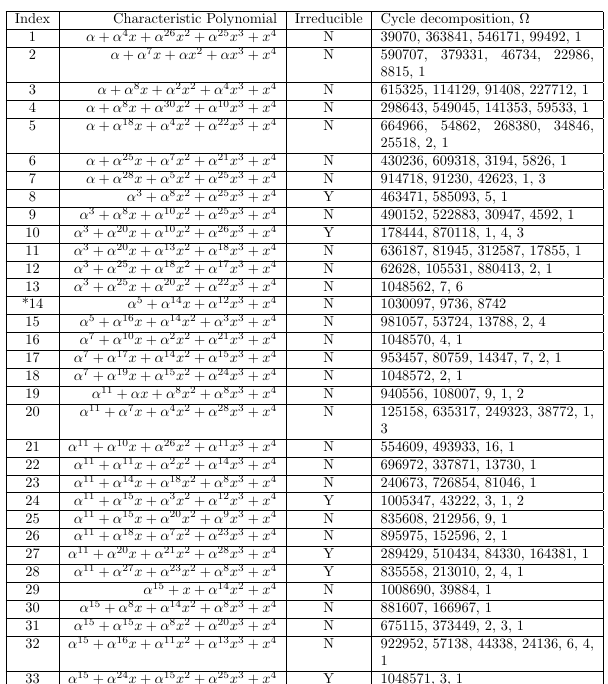
Table 2. Complete cycle decompositions of the WG- NLFSR for n = 4 over F 2